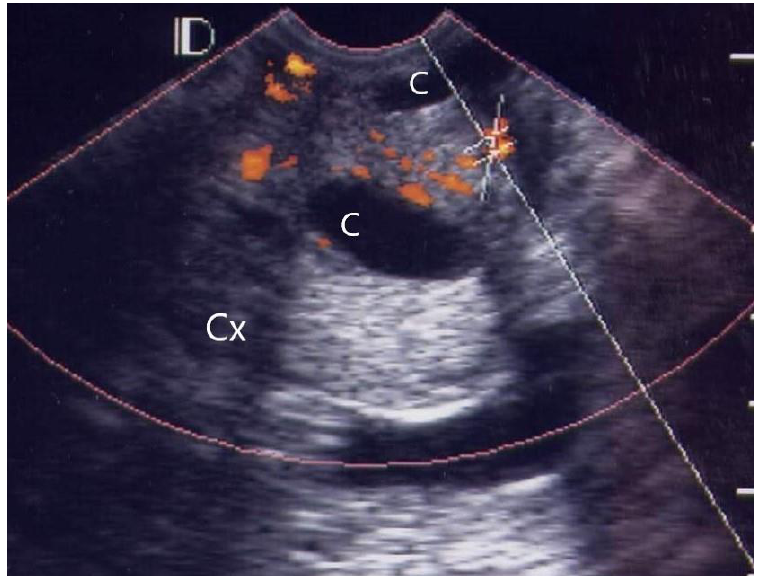
Figure 2. GRADE 2. A case of 29 years old female with pelvic inflammatory disease and tubo-ovarian abscess, more than 5 vascular spots (orange color) are located between two small cervical cysts, but not involve the endocervical canal. (C: Nabothian cyst, Cx: Cervix).